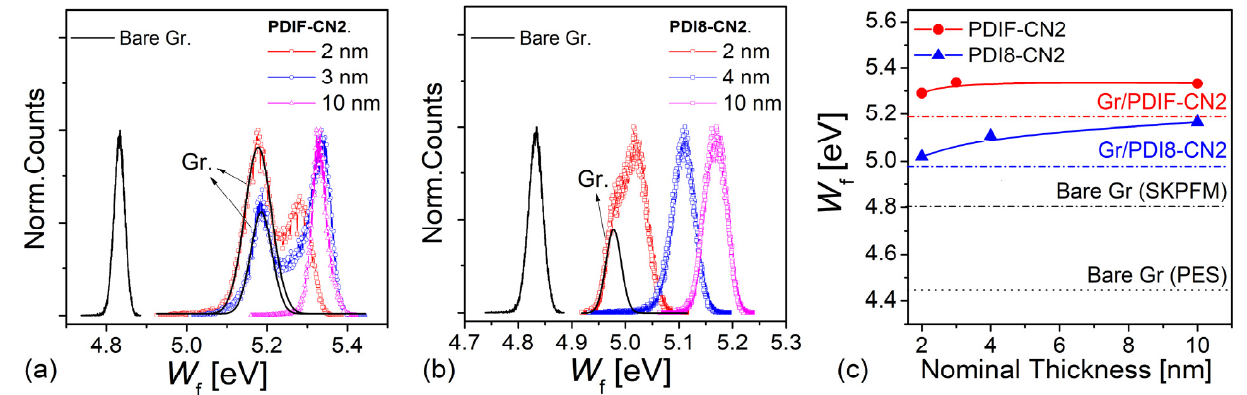
Figure 6. Statistical distributions of WF values retrieved from the calibrated SKPFM analysis for ( a ) PDIF-CN2 and ( b ) PDI8-CN2 considering the various organic thin film nominal thicknesses. The data are compared to the case of a bare graphene sample used as reference (black line). Panel ( c ) summarizes the evolution of the WF peaks for the organic semiconductors as a function of the thickness. The dashed-dotted lines individuate the graphene substrate contribution as retrieved from the sub-monolayer case (2 nm). The data are also compared to the WF of the bare graphene surfaces centered in the vicinity of 4.41 eV, as deduced by the UPS analysis in UHV conditions (black dotted line).